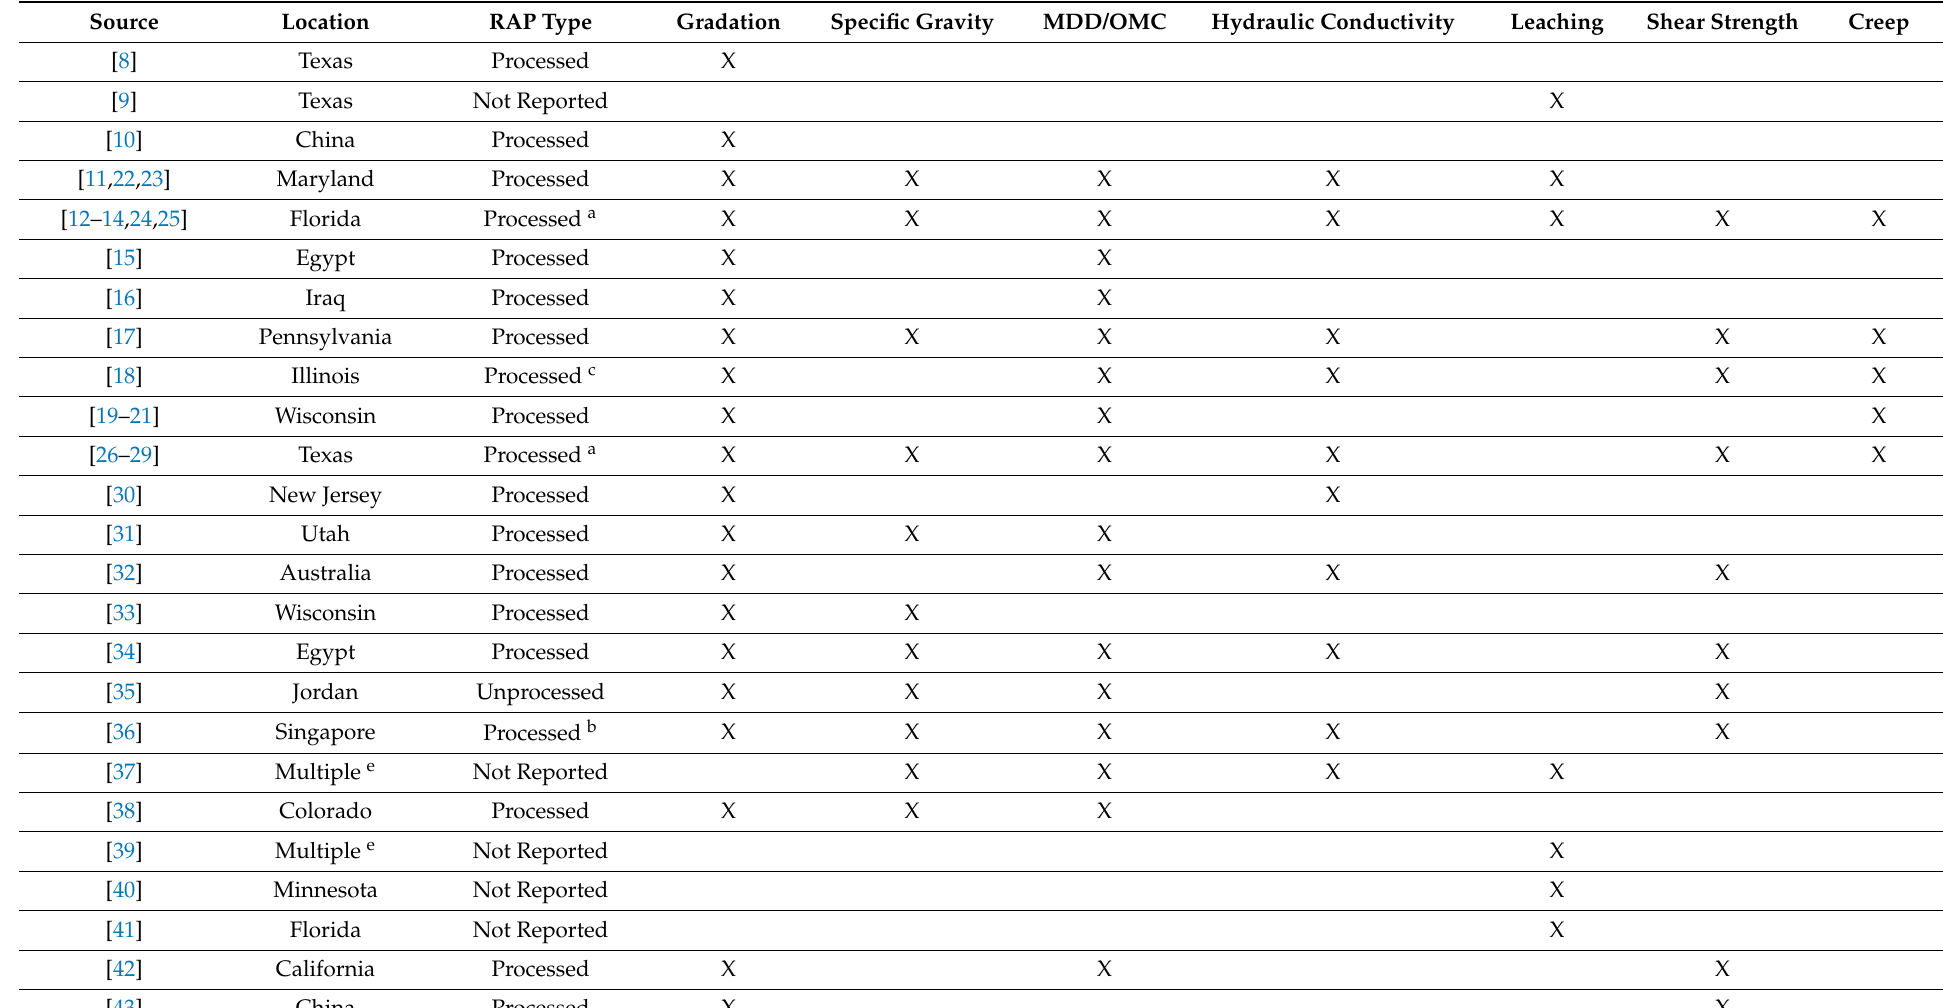
Table 1. Studies considered in this literature review, organized by the RAP geotechnical properties that were